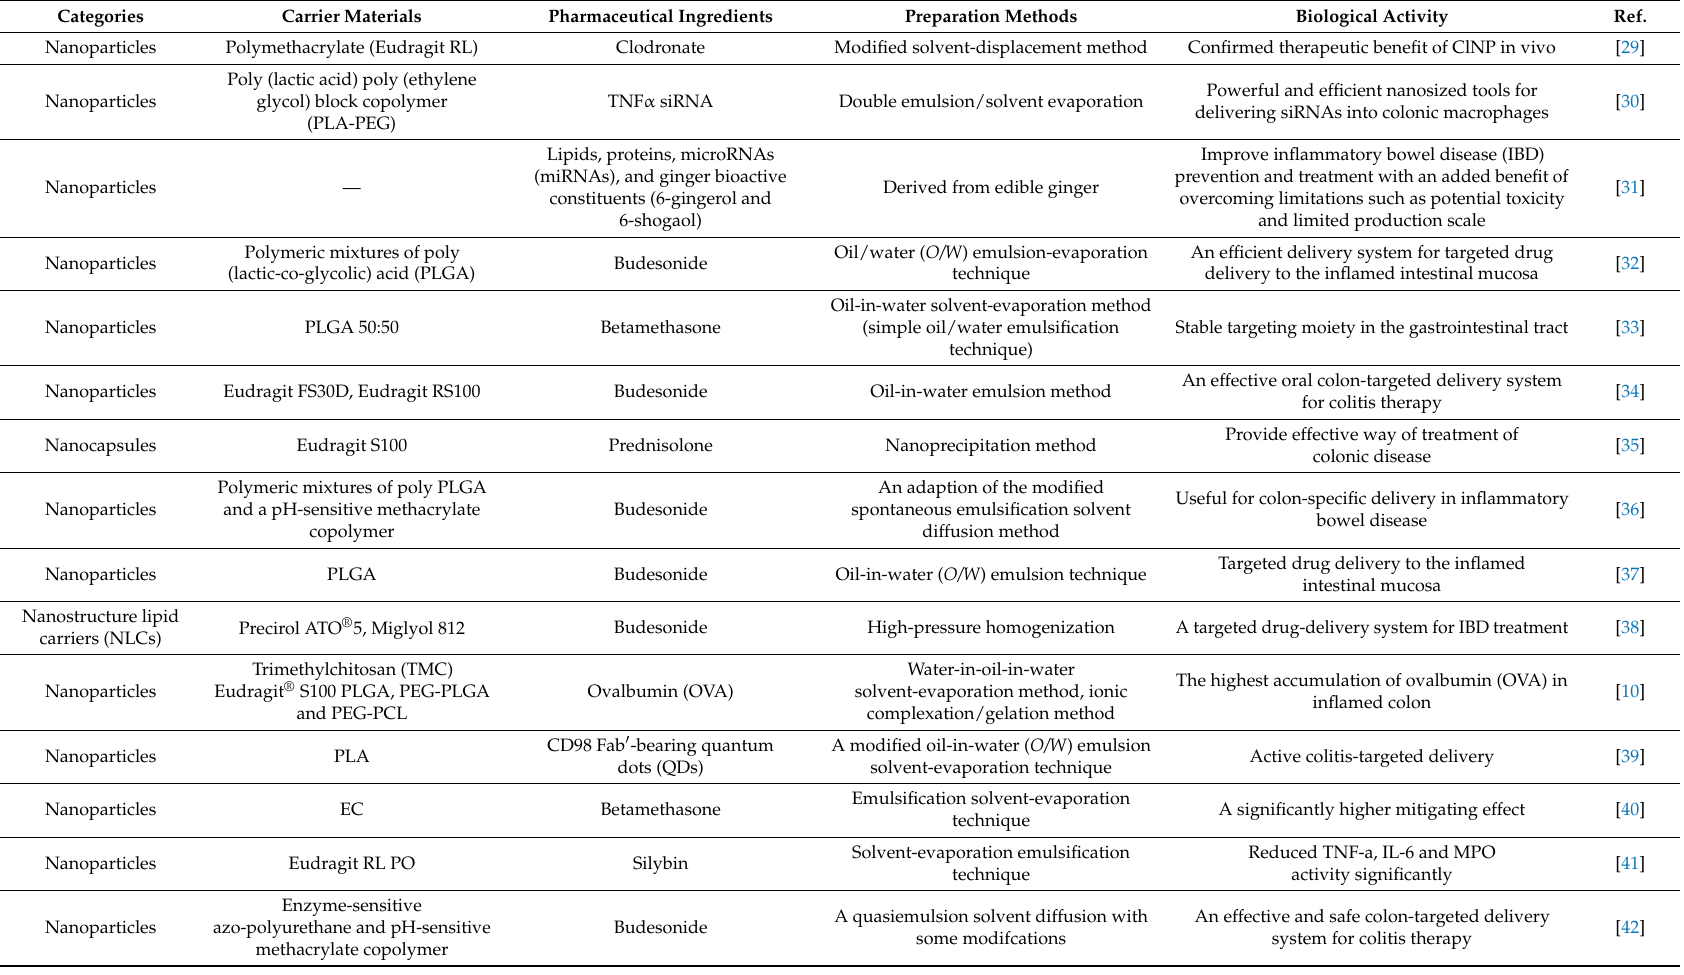
Table 1. Studies on the formula, preparation method and biological activity of different nanoparticles in treating ulcerative colitis